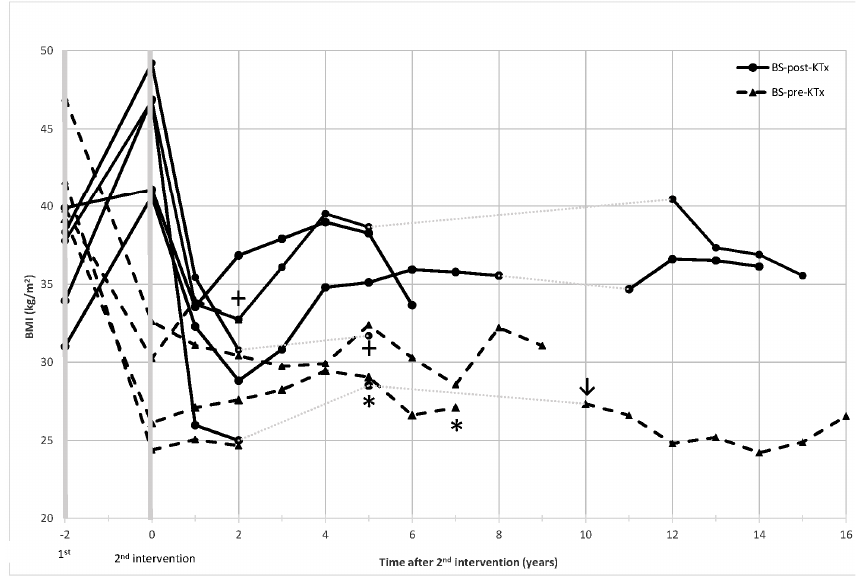
Figure 1. Body mass index trajectories after bariatric surgery (BS) or kidney transplantation (KTx). The 1st surgery refers to KTx for BS-post-KTx, and to BS for BS-pre-KTx. The 2nd intervention refers to BS for BS-post-KTx group, and to KTx for BS-pre-KTx. The time lapse (from 1 to 5 years) between both interventions is not scaled. The cross (+) indicates death and the asterisk (*), renal replacement therapy. The arrow ( ↓ ) indicates that one patient categorized into BS-post-KTx group received a 2nd KTx following BS (reclassification into BS-pre-KTx